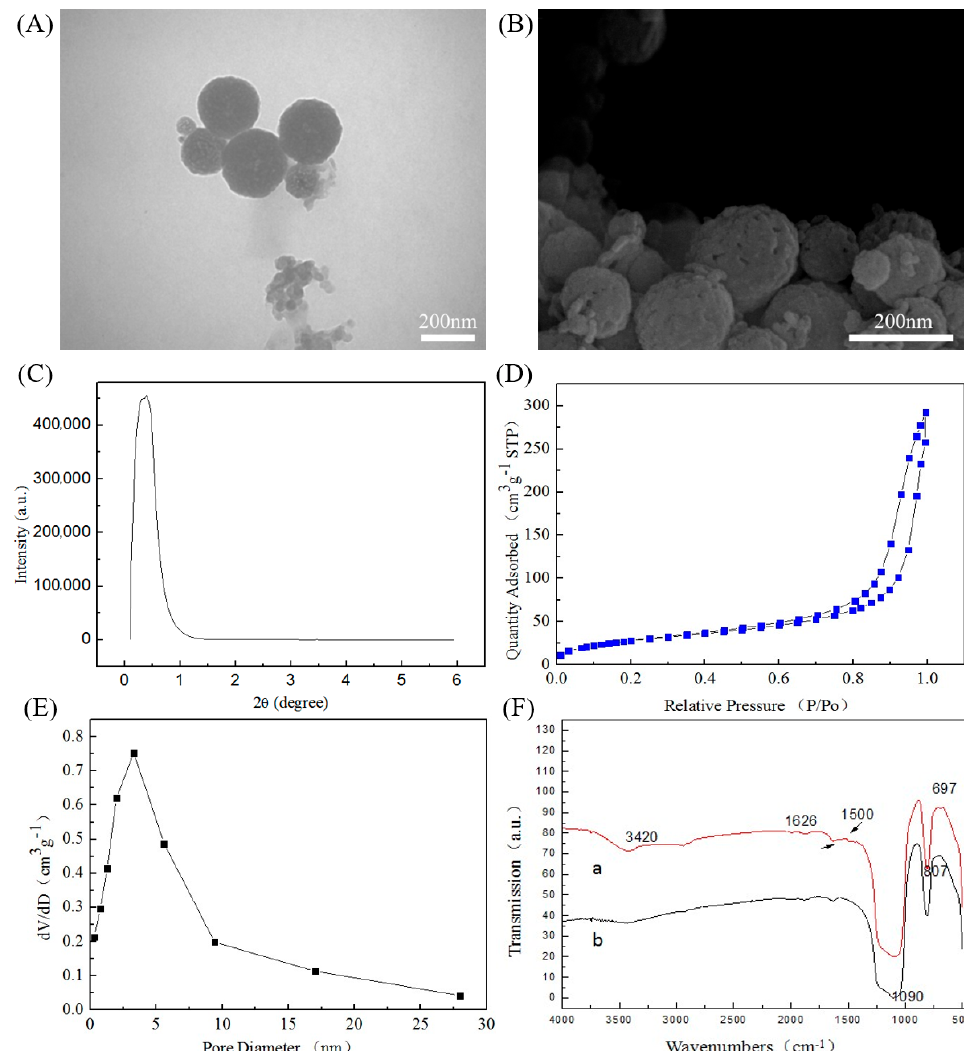
Figure 2. The characteristics of mesoporous SiO 2 nanoparticles: ( A ) transmission electron microscope; ( B ) scanning electron microscope; ( C ) XRD pattern of mesoporous SiO 2 nanoparticles; ( D ) mesoporous SiO 2 nanoparticle isotherm; ( E ) BET pore size analysis chart of mesoporous SiO 2 nanoparticles; ( F ) infrared spectrum of aminated mesoporous SiO 2 nanoparticles: ( a ) mesoporous SiO 2 nanoparticles after amination; ( b ) mesoporous SiO 2 nanoparticles without